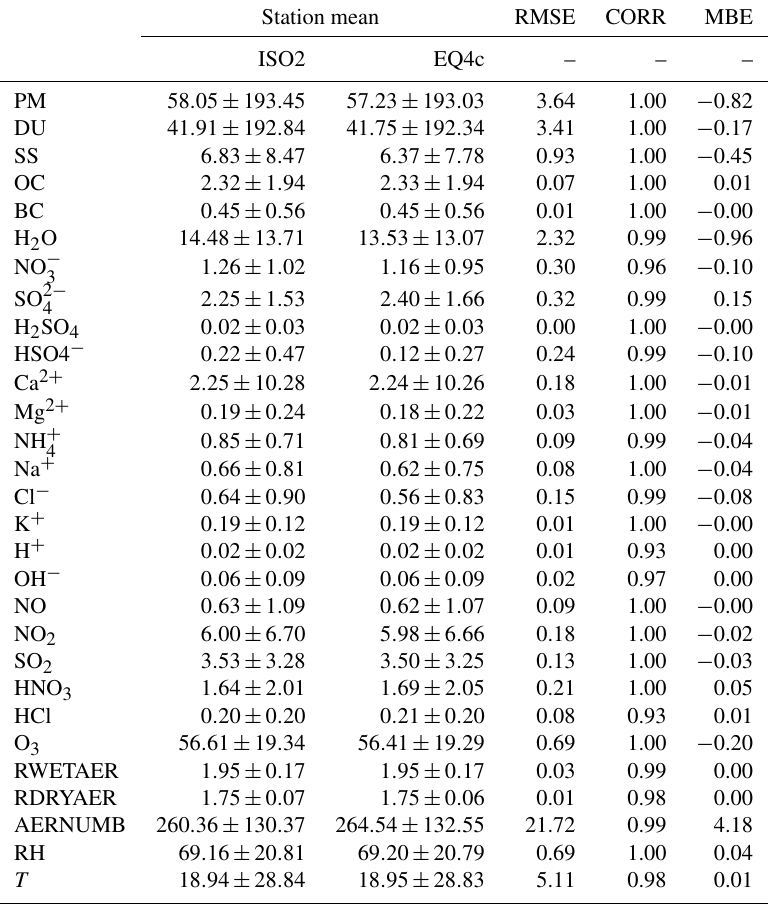
Table 3. EMAC tracer statistics for the year 2005 and 189 stations based on 5-hourly model output. Simulations based on ISORROPIA II (ISO2) and EQSAM4clim (EQ4c) (identical EMAC setup).